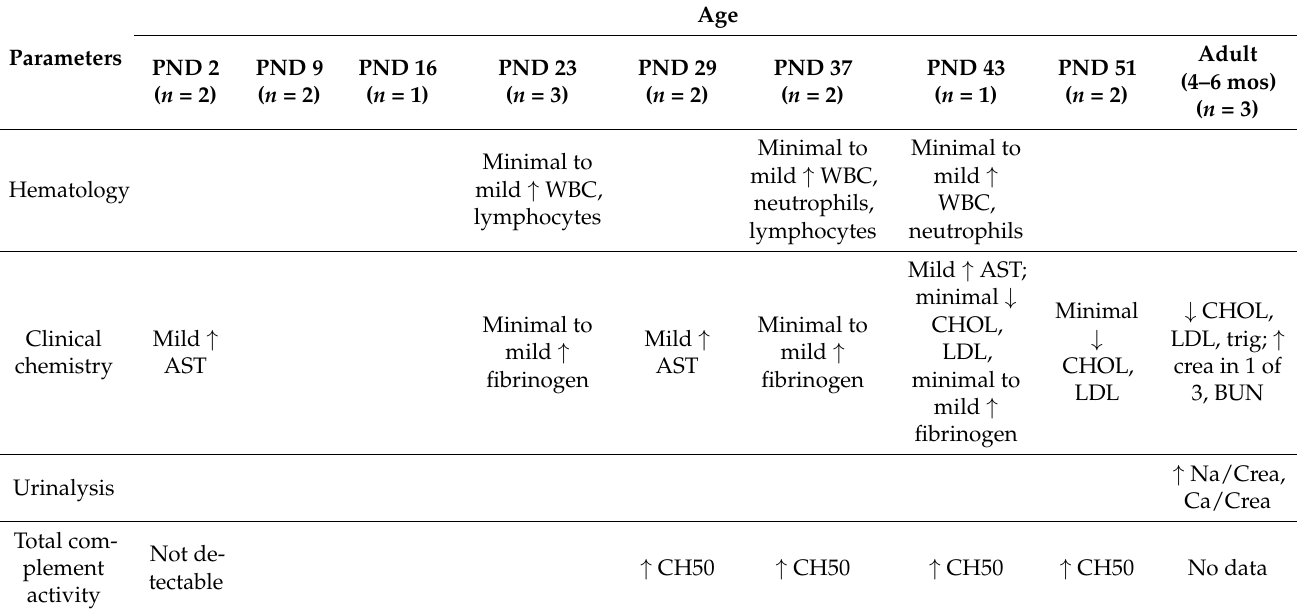
Table 2. Clinical pathology evaluation overview. Comparison with published adult data [31] after RTR5001 administration.